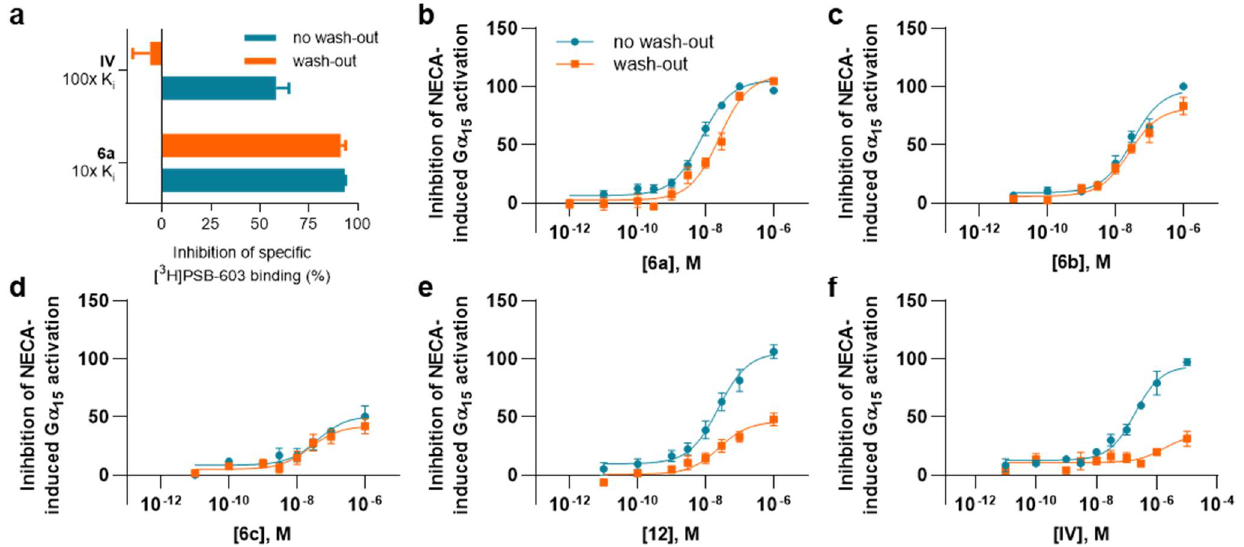
Figure 6. Binding and functional characterization of the A 2B AR K269 7.32 L mutant. ( a ) Wash-out experiments after incubation of the A 2B AR mutant with compounds 6a and IV at 10-fold of the K i value and at 100-fold of the K i value, respectively. After an extensive washing procedure, the specific binding of [ 3 H]PSB-603 was determined. Data represents normalized mean values ± SEM from three independent experiments. ( b – f ) Concentration-response curves for ( b ) PSB-21500 ( 6a ), ( c ) PSB-21501 ( 6b ), ( d ) PSB-21502 ( 6c ), ( e ) PSB-21503 ( 12 ), and ( f ) PSB-1115 ( IV ) showing the percent inhibition of NECA-induced Gα 15 activation by the investigated antagonists at the A 2B AR K267 7.32 L mutant.